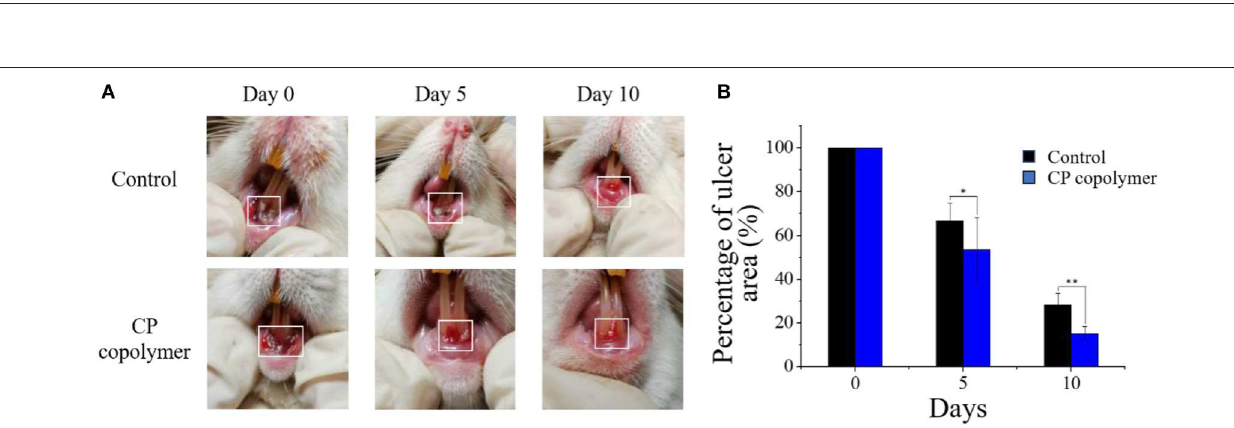
FIGURE 4 | (A) Pictures of blood incubated with the CP copolymer (5 wt%) in a microcentrifuge tube after 30s of treatment in a water bath at 37 ◦ C. (B) Coagulation time was quantified, for which samples from the control group were assigned the maximum clotting time for the assay as they did not clot. ** p < 0.01.